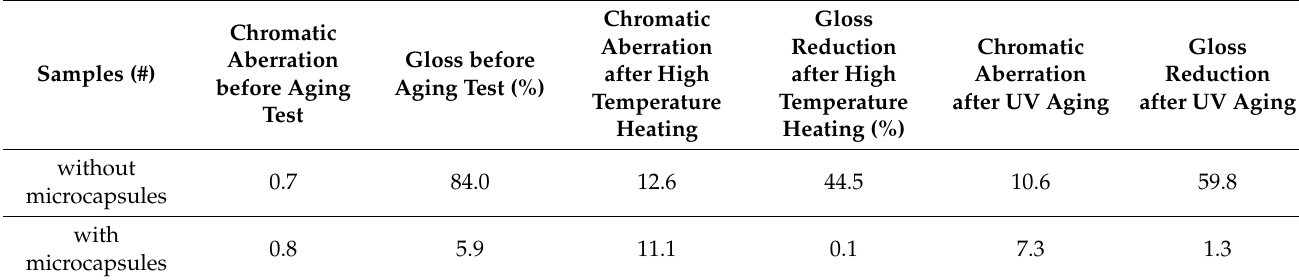
Figure 16. Scratch width of the coating with microcapsules: ( A ) scratch image and ( B ) scratch im- age after 48 h.